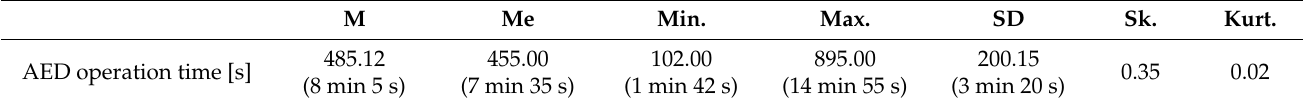
Table 2. Baseline statistics for AED use time ( n = 33). M Me Min. Max. SD Sk. Kurt.